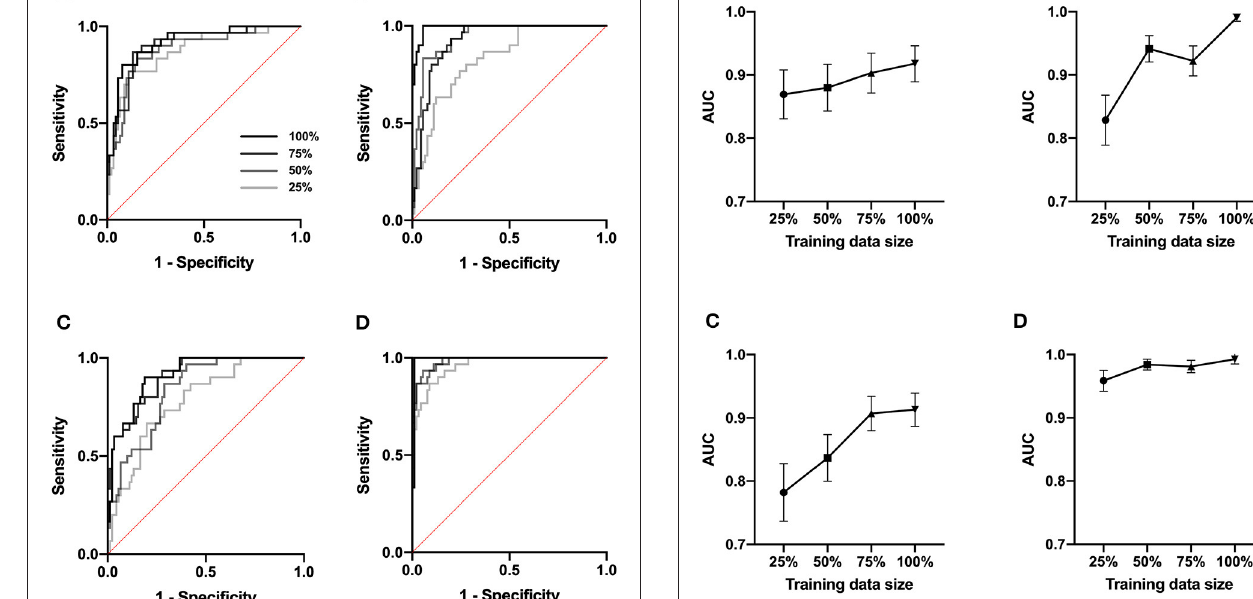
( Figure 2D ), with an increase in the number of data points.